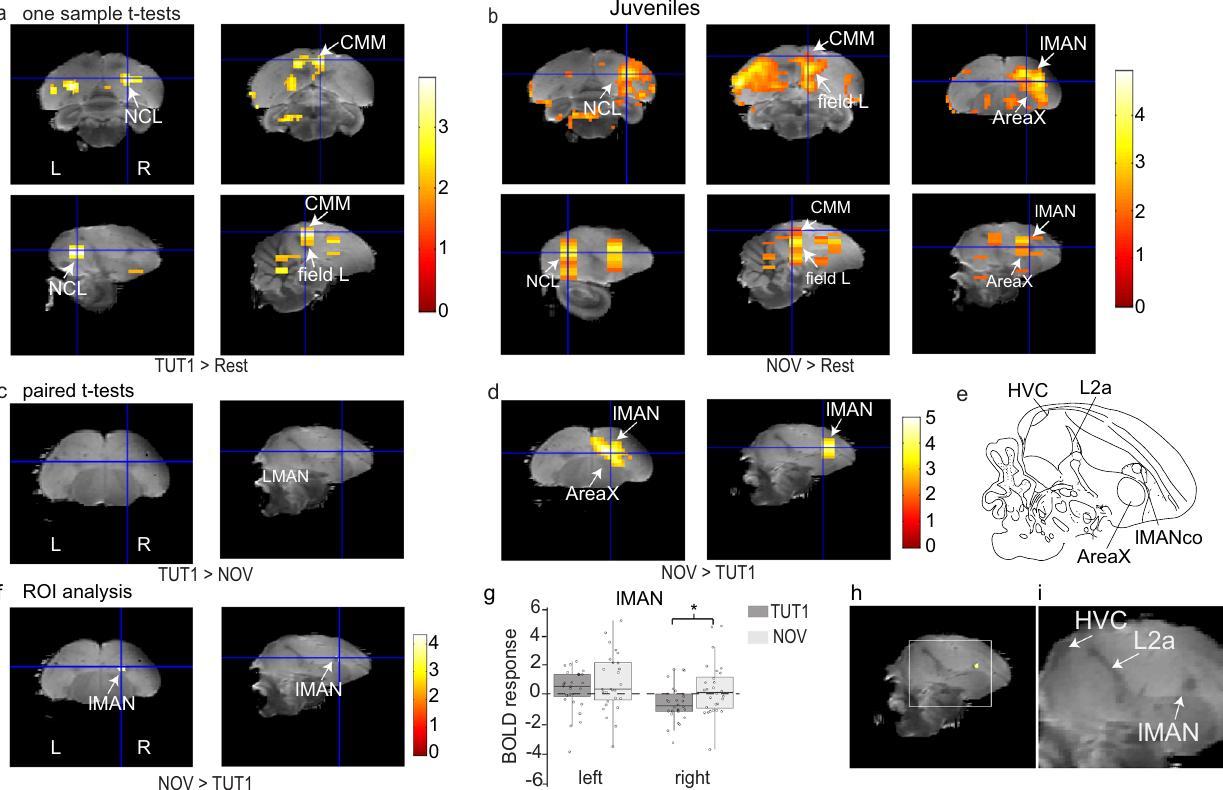
Fig. 2 Brain regions activated by song in 55-day-old birds. a , b Statistical map of voxels activated by song superimposed on coronal and corresponding (indicated with cross hair) parasagittal sections of the high-resolution atlas of the zebra fi nch brain 84 . Only voxels with t > 1.76 (one-sample t tests, exploratory threshold P uncorrected < 0.05) are displayed (A: TUT1 > rest; B: NOV > rest); t-values are color-coded based on the scale on the right. c , d Paired t tests show a signi fi cantly higher BOLD response in forebrain regions, including lMAN, in response to novel song (NOV vs. TUT1 playback). All voxels with t > 2.47 are displayed (paired t tests, P uncorrected < 0.01) and t-values are color-coded based on the scale displayed in the fi gure. e Line drawing of a parasagittal section from the zebra fi nch histological atlas 90 . f Region-of-interest (ROI) analysis restricted to lMAN shows a higher BOLD response to NOV vs. TUT1 in the right lMAN. g Boxplot of BOLD response ( β weights) for each stimulus relative to rest periods within lMAN (indicated with a white arrow in ( f )). Boxplots showing the interquartile range (box), median (black line), and 1st and 3rd quartile; each circle represents data from one individual bird (* P FWE < 0.05, N = 28). For visual representation, one data point (bold estimate = − 9.50416, left hemisphere, NOV) was excluded from the fi gure but not from the statistical analysis. h , i Detailed views of the exact location of the activated cluster observed within lMAN. NCL: caudolateral Nidopallium, CMM: caudomedial Mesopallium, lMANco: core of the lateral magnocellular nucleus of the anterior Nidopallium, L2a: sub fi eld L2a of fi eld L. HVC and Field L are used as proper